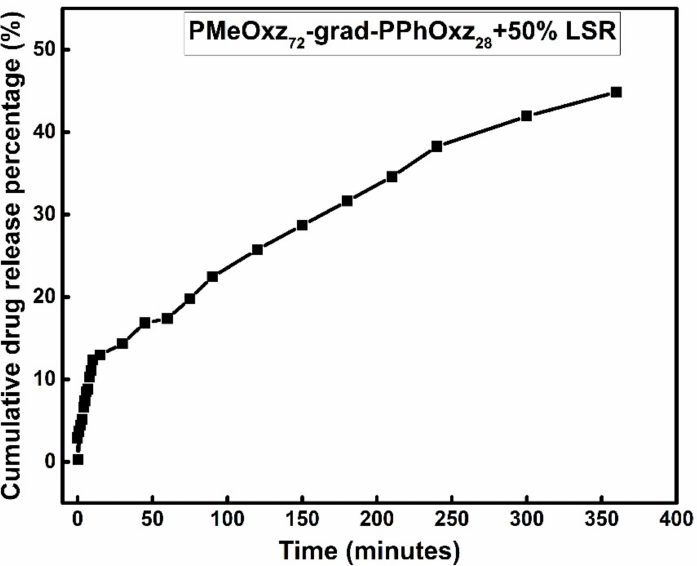
Figure 12. Release of LSR from PMeOxz 72 -grad-PPhOxz 28 nanoassemblies in aqueous media under